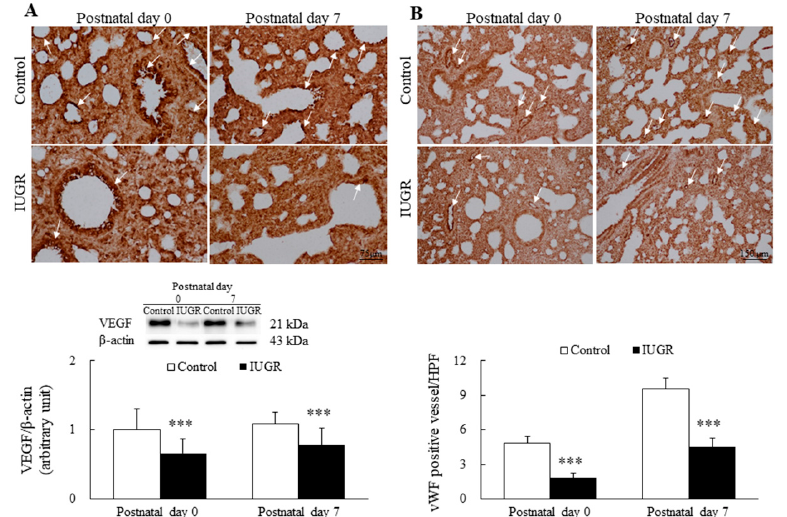
Figure 2. ( A ) Representative immunohistochemical images and Western blots of vascular endothelial factor (VEGF) and ( B ) representative immunohistochemical images for von Willebrand factor (vWF) and the results of semiquantitative vascular density analysis of control and IUGR rats on postnatal days 0 and 7. VEGF immunoreactivities (white arrow) were primarily detected in the endothelial and epithelial cells. Control rats exhibited similar VEGF and vWF immunoreactivities on postnatal days 0 and 7. By contrast, the VEGF expression, vWF immunoreactivity, and vascular density (white arrow) of the IUGR group were significantly lower than those of the control group on postnatal days 0 and 7. n = 7 rats at each postnatal day. Data are presented as means ± standard deviations. *** p < 0.001.